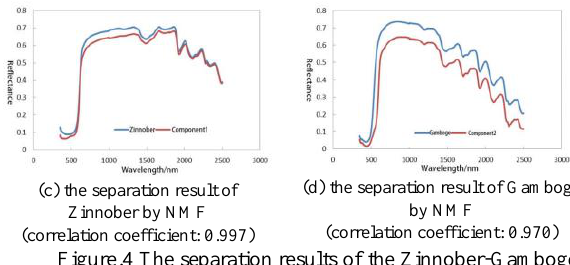
Figure.4 The separation results of the Zinnober-Gamboge group